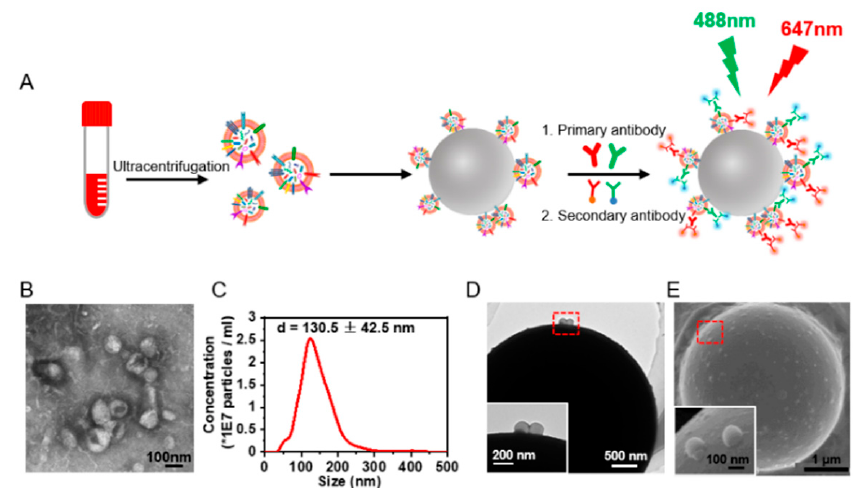
Figure 1. Extraction and microbead enrichment of sEVs. ( A ) Schematic illustration of microbead enrichment of sEVs from serum and immunostaining of the sEVs. The sEVs were enriched on 4- µ m aldehyde/sulphate latex beads and were stained with anti-EGFR and anti-CXCR4 and the fluorescent-tagged secondary antibody to yield detectable signals for flow cytometry analysis of EGFR+ and CXCR4+ sEVs. ( B ) TEM images of sEVs released from A549 cells. ( C ) Size distribution of sEVs released from A549 cells analyzed by NTA. ( D , E ) TEM ( D ) and SEM ( E ) images of sEVs enriched on the microbeads. Inset: zoom-in images of the bead-bound sEVs in the red dashed